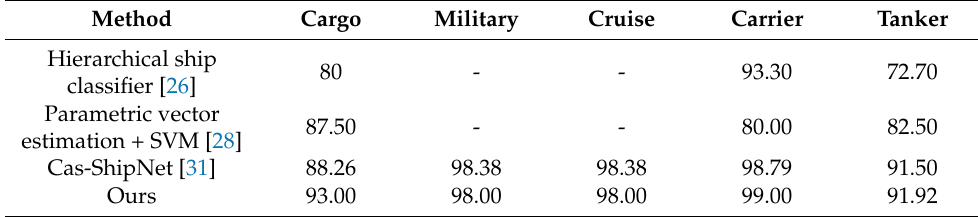
Table 7. Classification comparison of different ship classes with state-of-the-art algorithms. Method Cargo Military Cruise Carrier